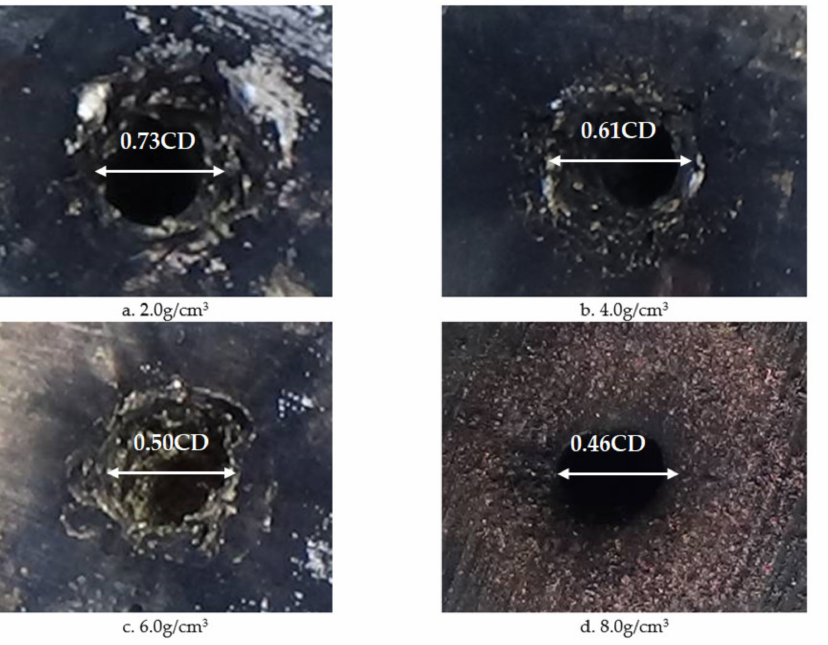
Figure 20. Experimental images of shaped charges with different densities acting on a steel